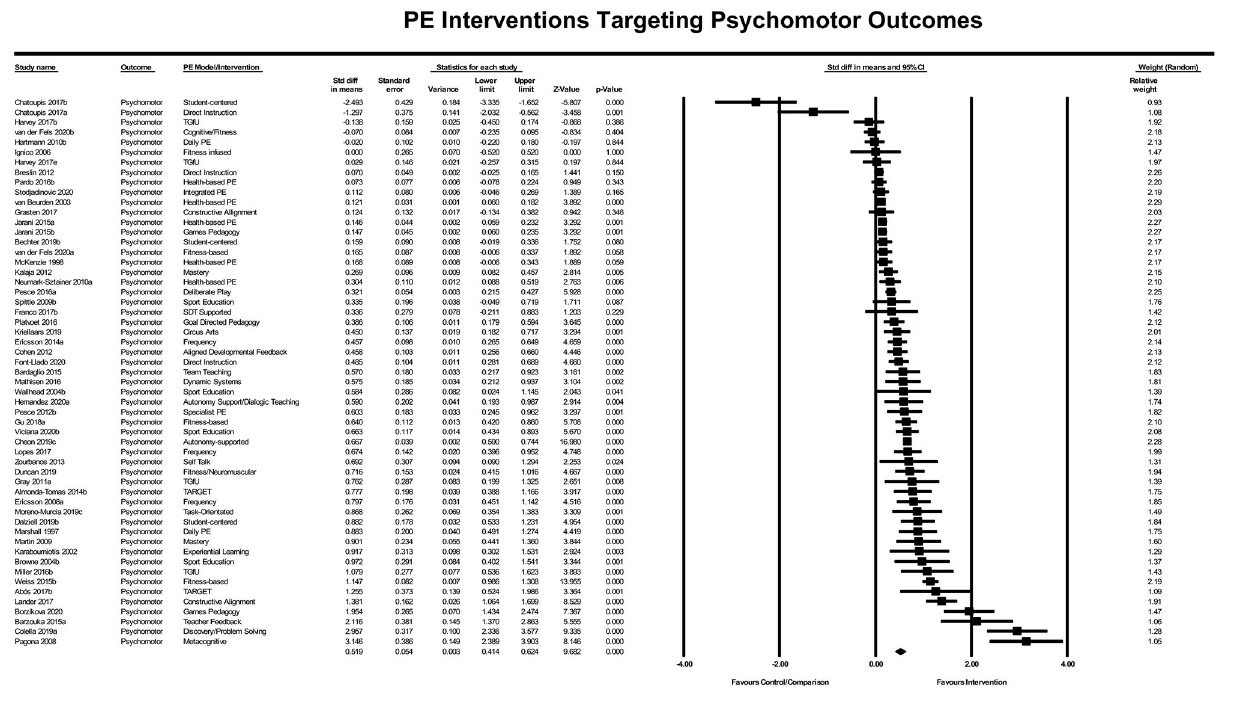
FIGURE 7 | Forrest plot of standardized difference in means of psychomotor PE